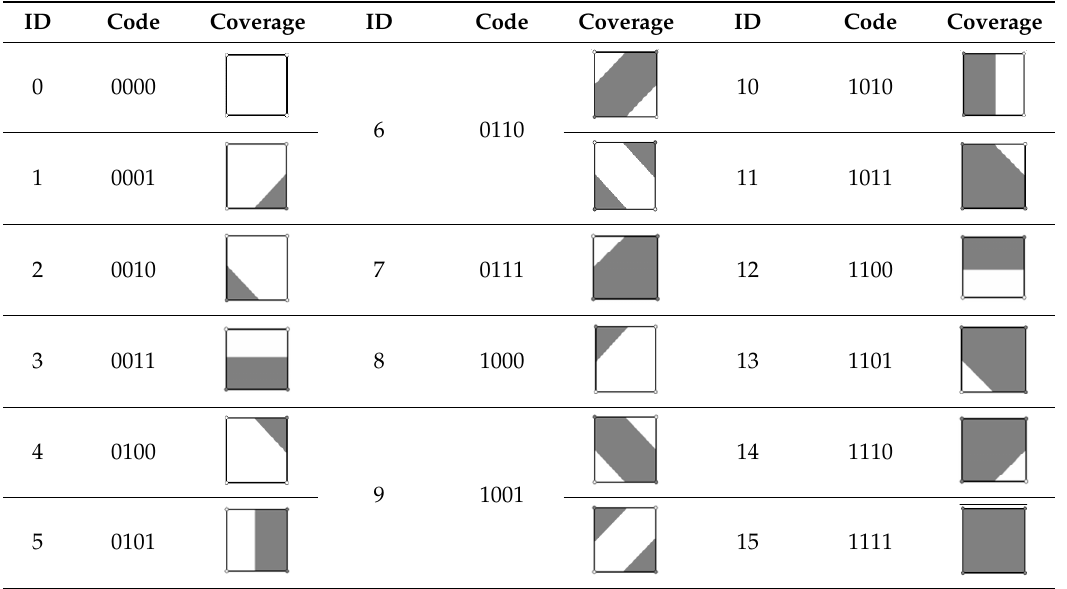
Figure 3. Profile of an object point, obstacle and camera.